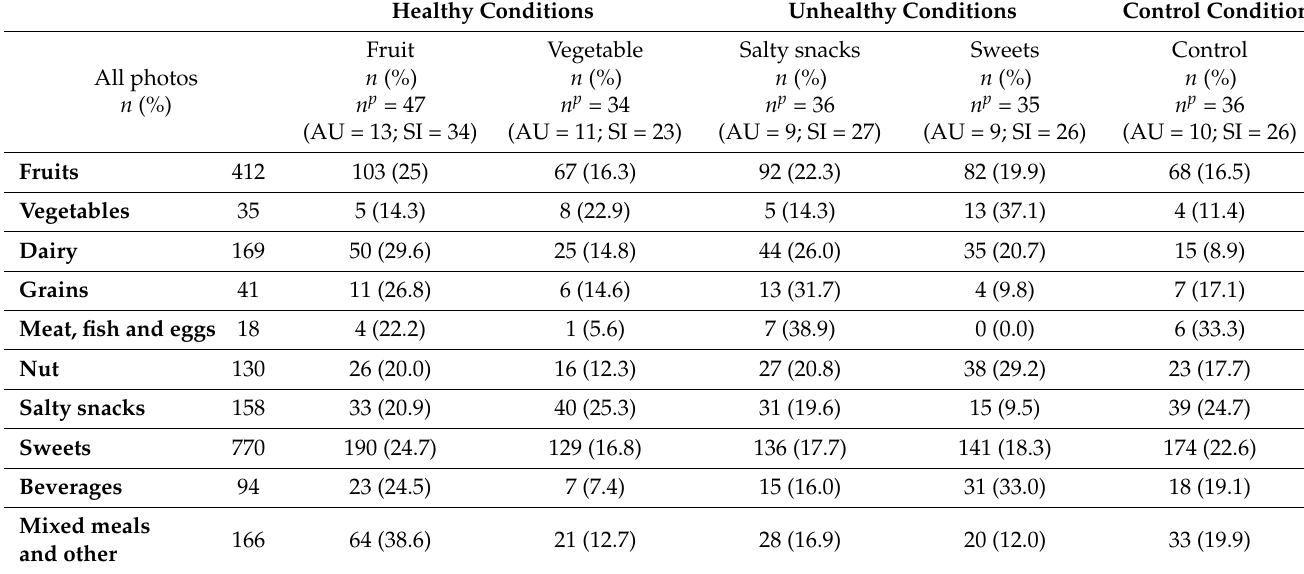
Table 3. Food groups of snacks per